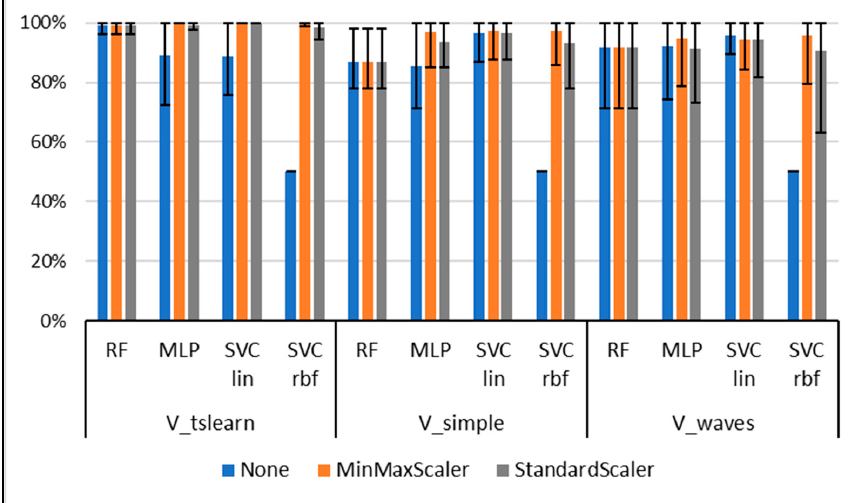
Figure 1. Classification accuracy (mean, min, max value) for the different input vectors, classification algorithms, and normalization approaches over the 5-fold cross-validation. RF = Random Forest; MLP = multilayer perceptron; SVM lin = Support Vector Machine with linear kernel; SVM rbf = Support Vector Machine with radial basis function